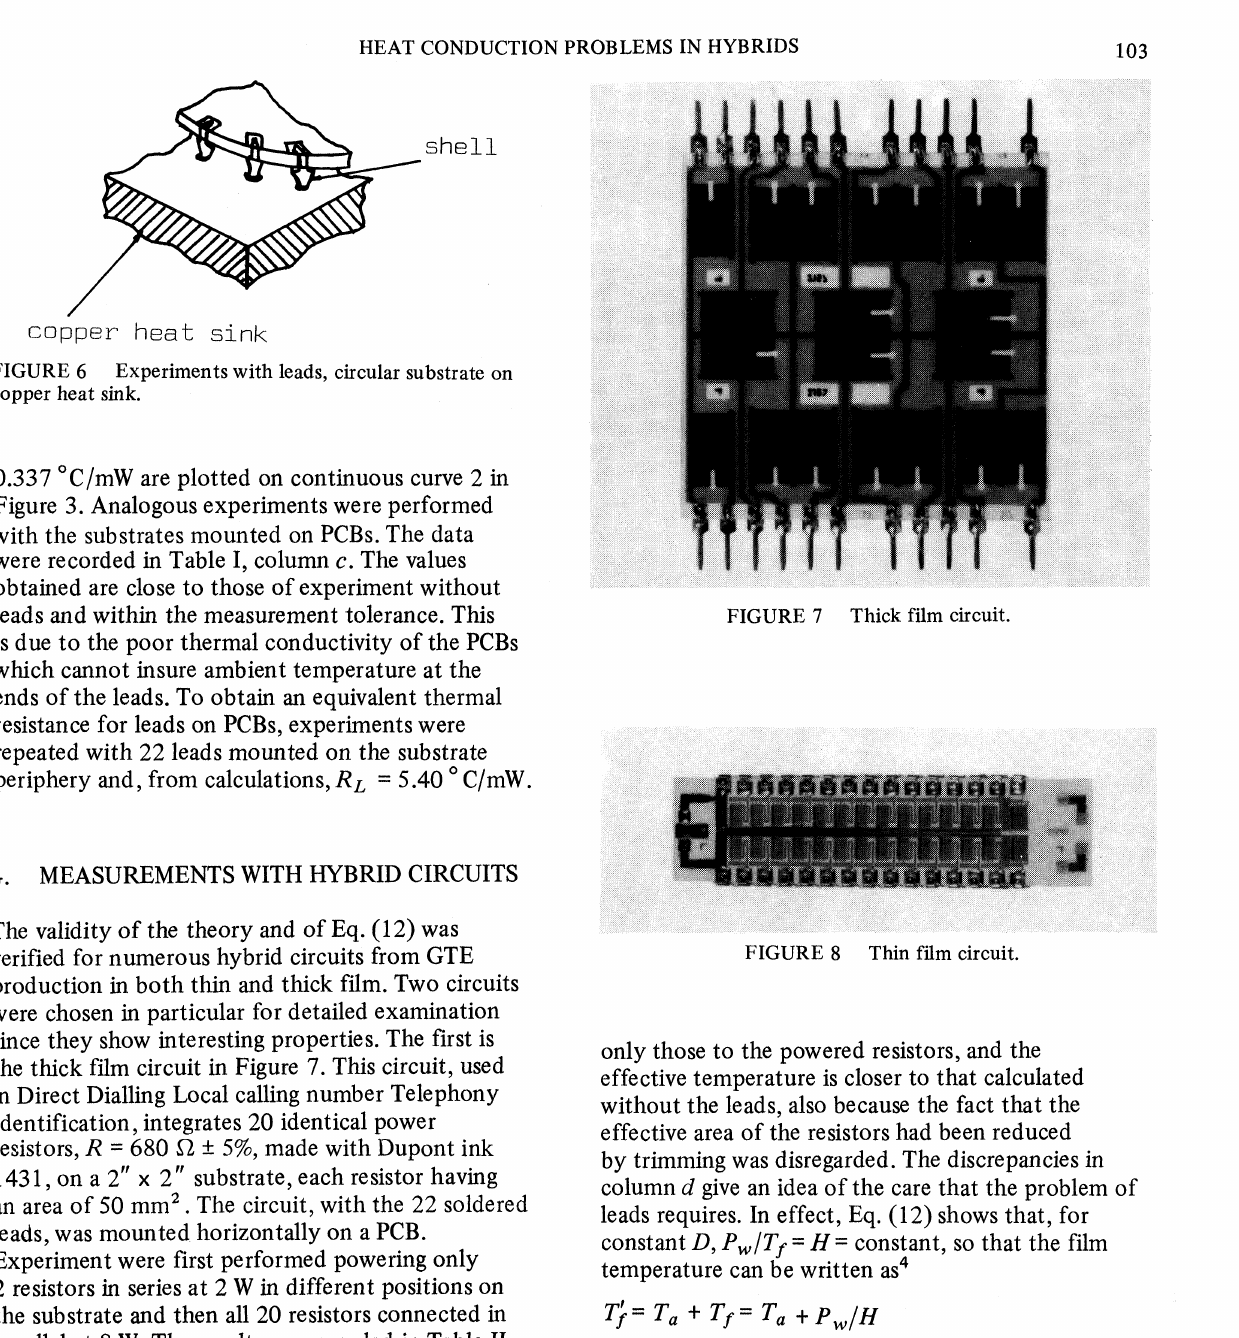
Experiments with leads, circular substrate on copper heat sink.